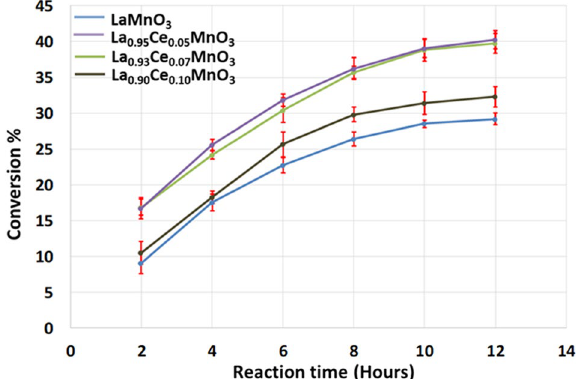
Figure 9. Graphical illustration of the kinetic of the reaction carried out using La 1 − x Ce x MnO 3 catalysts. Conditions: catalyst = 0.3 g, T = 393 K, benzyl alcohol = 2 mmol, toluene = 10 mL, O 2 flow rate = 10 cm 3 min − 1 , reaction time = 12 h.